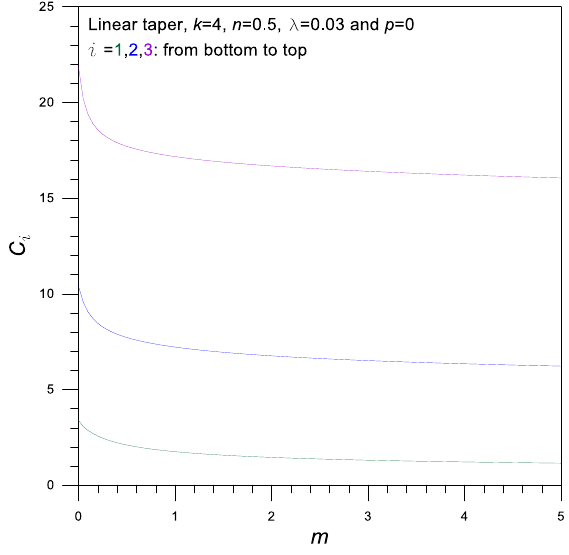
Figure 3. Frequency parameter 𝐶 𝑖 versus modular ratio 𝑚 curves.